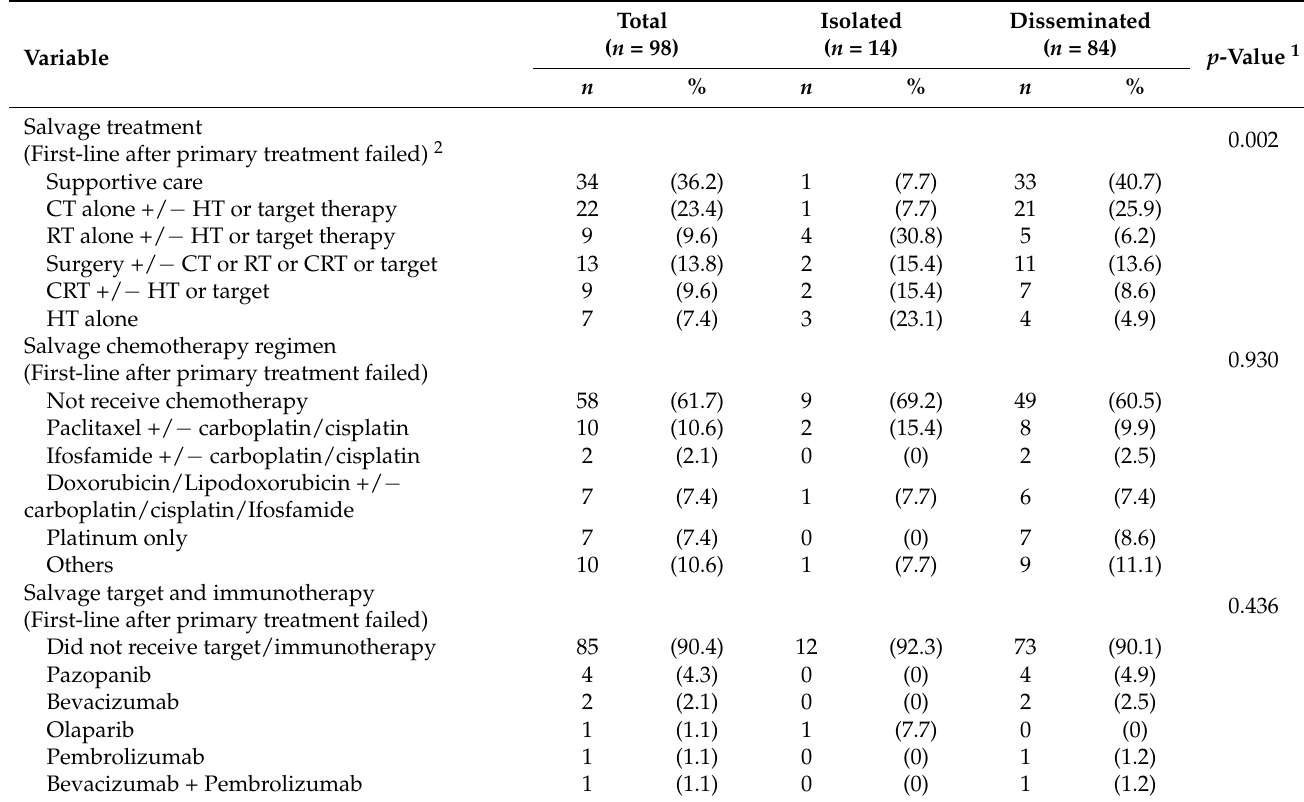
Table 2. Salvage therapies in recurrent/progression patients ( N =